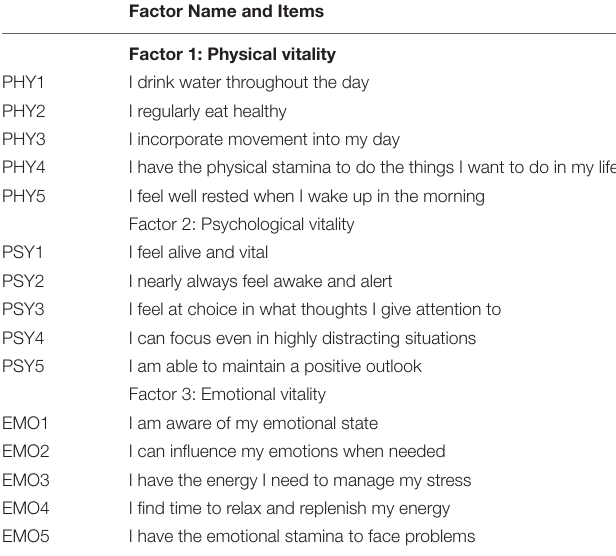
TABLE 1 | Initial 15 Items of the LVS. Factor Name and